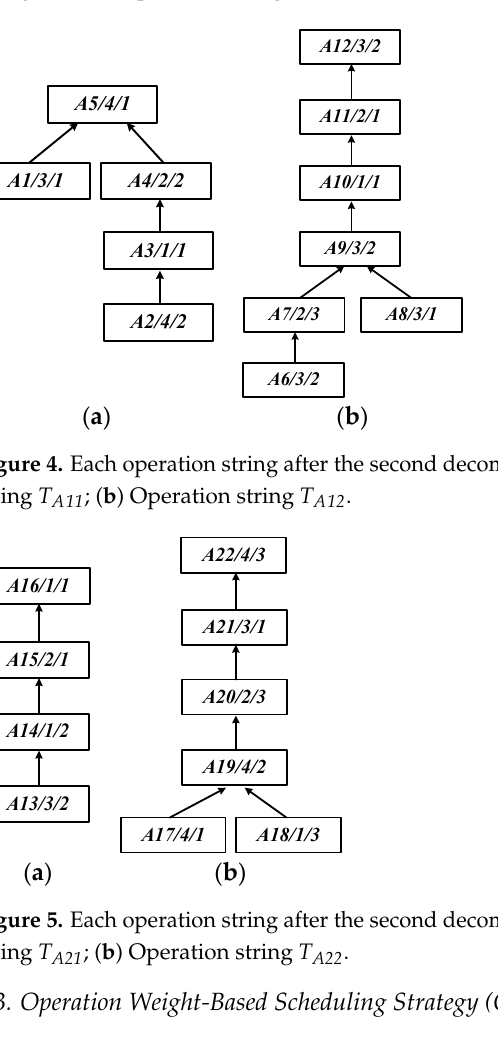
Figure 3. Each operation string after the first decomposition of complex product A : ( a ) Operation string T A1 ; ( b ) Operation string T A2 .